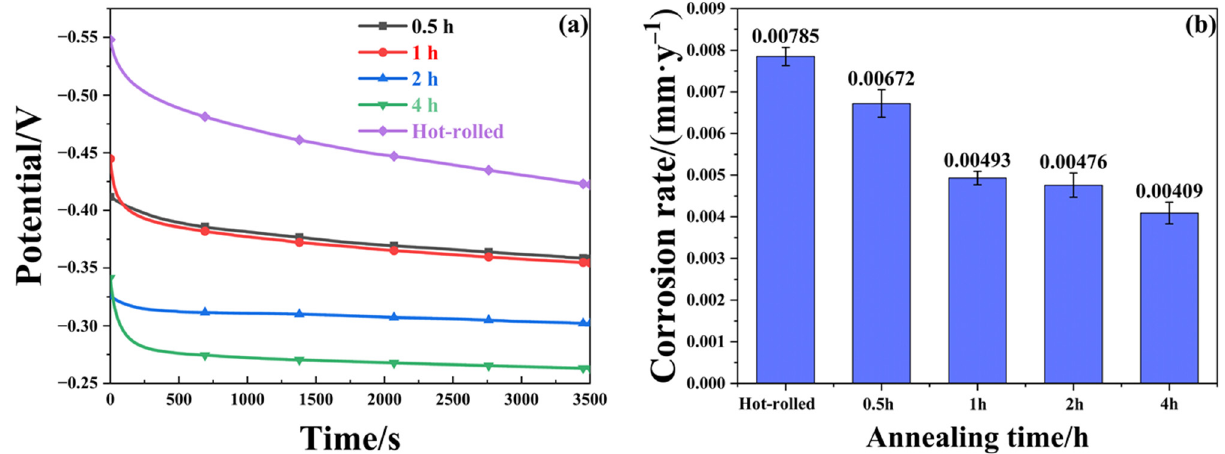
Figure 12. Corrosion resistance of TA10 alloy ( a ) OCP, ( b ) corrosion rate.